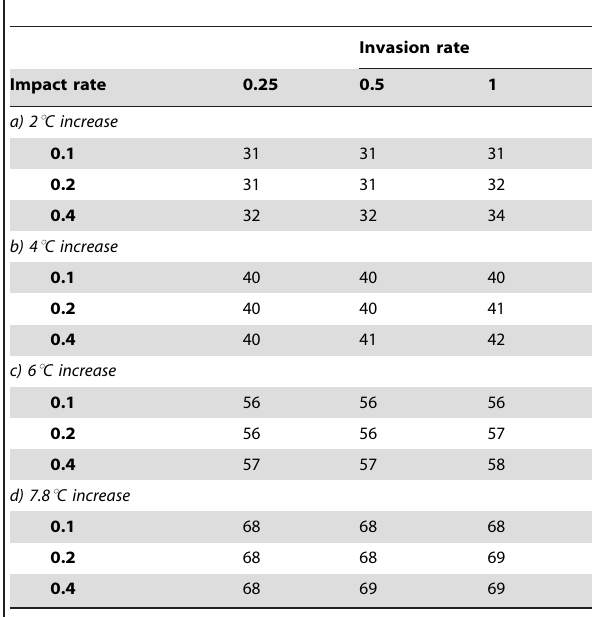
Table 4. Predicted cisco extirpations from a series of climate change and rainbow smelt invasion